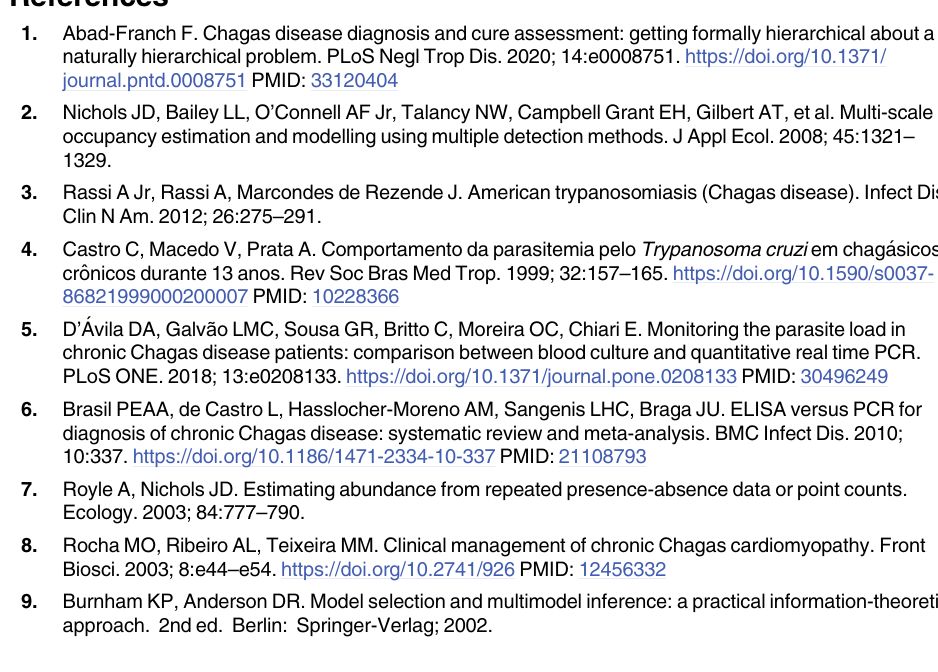
”, upper half; and 1/null/test+condition